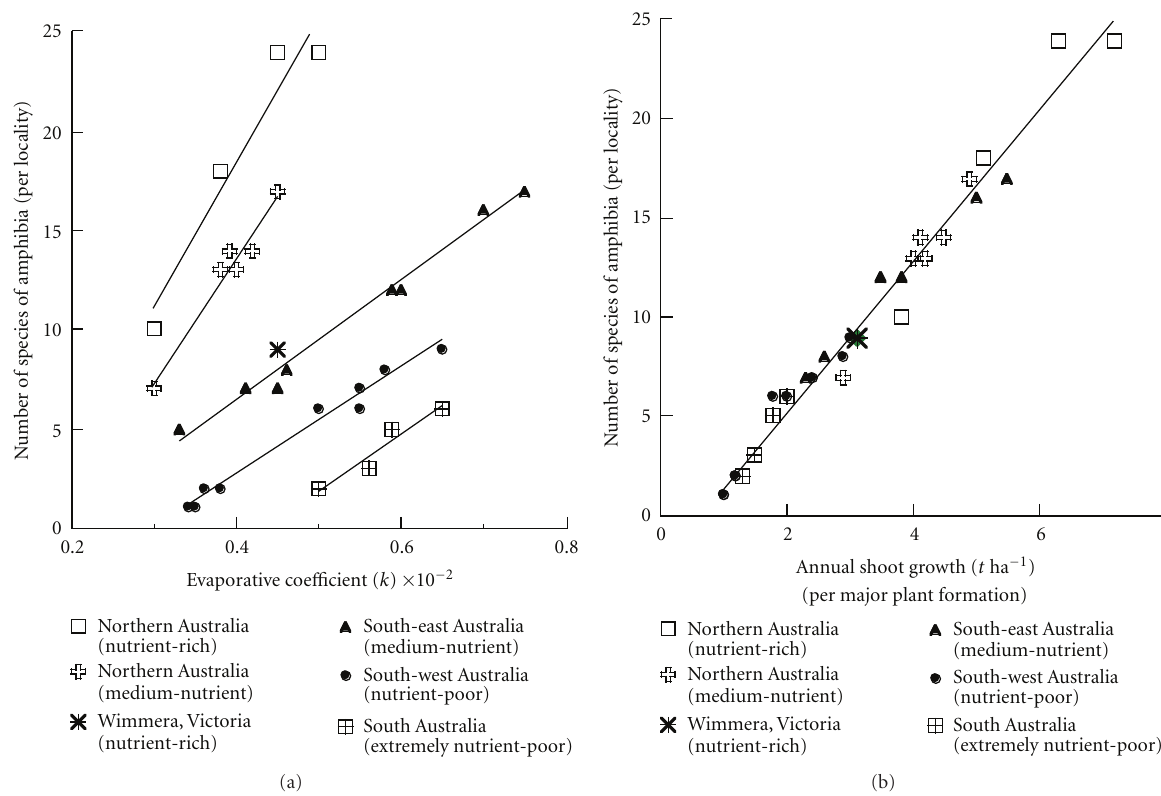
Figure 7: Number ( N ) of species of amphibians in nutrient-rich, medium-nutrient, nutrient-poor, and extremely nutrient-poor habitats in northern and southern Australia, plotted against the Evaporative Coe ffi cient ( k ) of the sampling locality (a), and plotted against the Annual Shoot Growth of the major plant formation at the sampling site (b)—(after